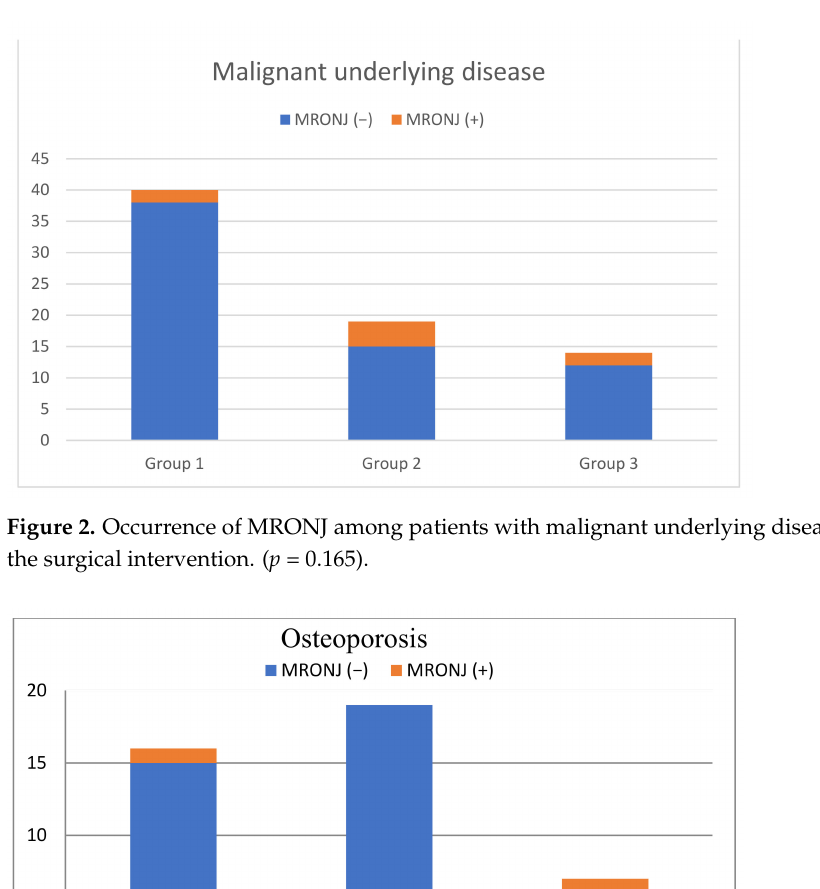
Figure 1. MRONJ among the three different types of surgical interventions (single tooth extraction (5.36%) ( p = 0.323); multiple extraction 10.53% ( p = 0.728); osteotomy 14.29% ( p = 0.387).